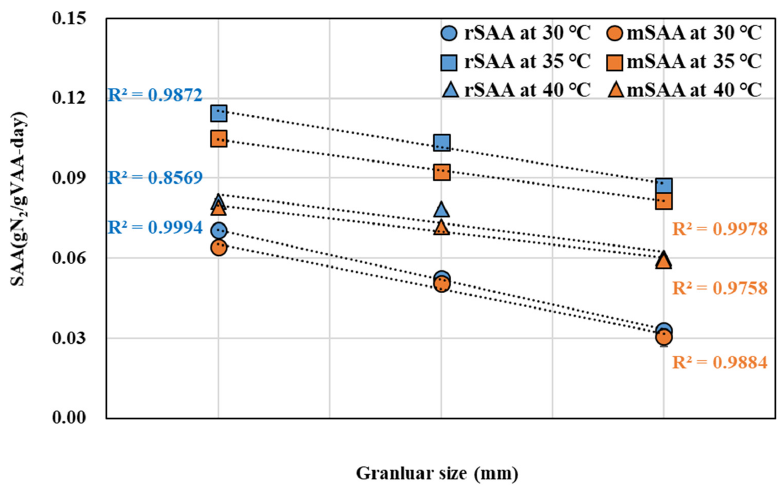
Figure 4. The rSAA and mSAA changes according to the granule size by temperature.